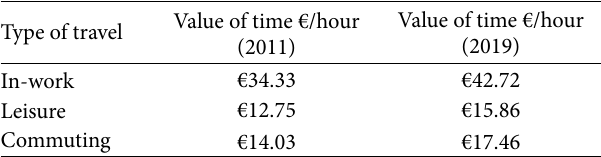
Table 1: Time distributions for dwell times (s). Table 2: Value of travel time